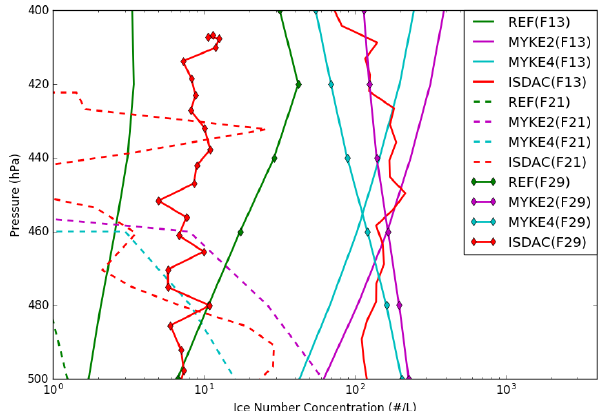
Figure 7. Comparison of the observed (red) and simulated (REF in green, MYKE2 in purple and MYKE4 in cyan) vertical profiles of N i along flights F13 (solid lines), F21 (dashed lines) and F29 (solid line with diamond